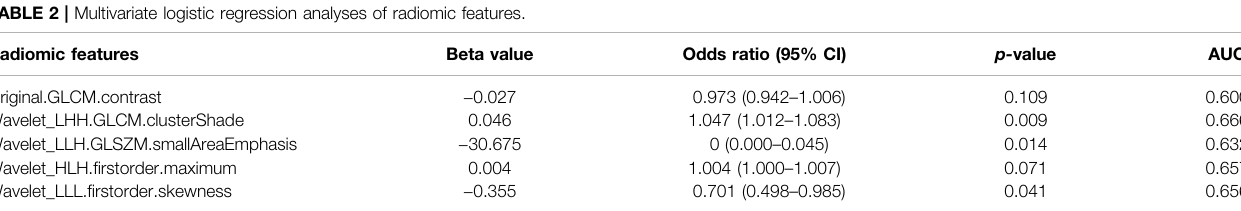
TABLE 2 | Multivariate logistic regression analyses of radiomic features. Radiomic